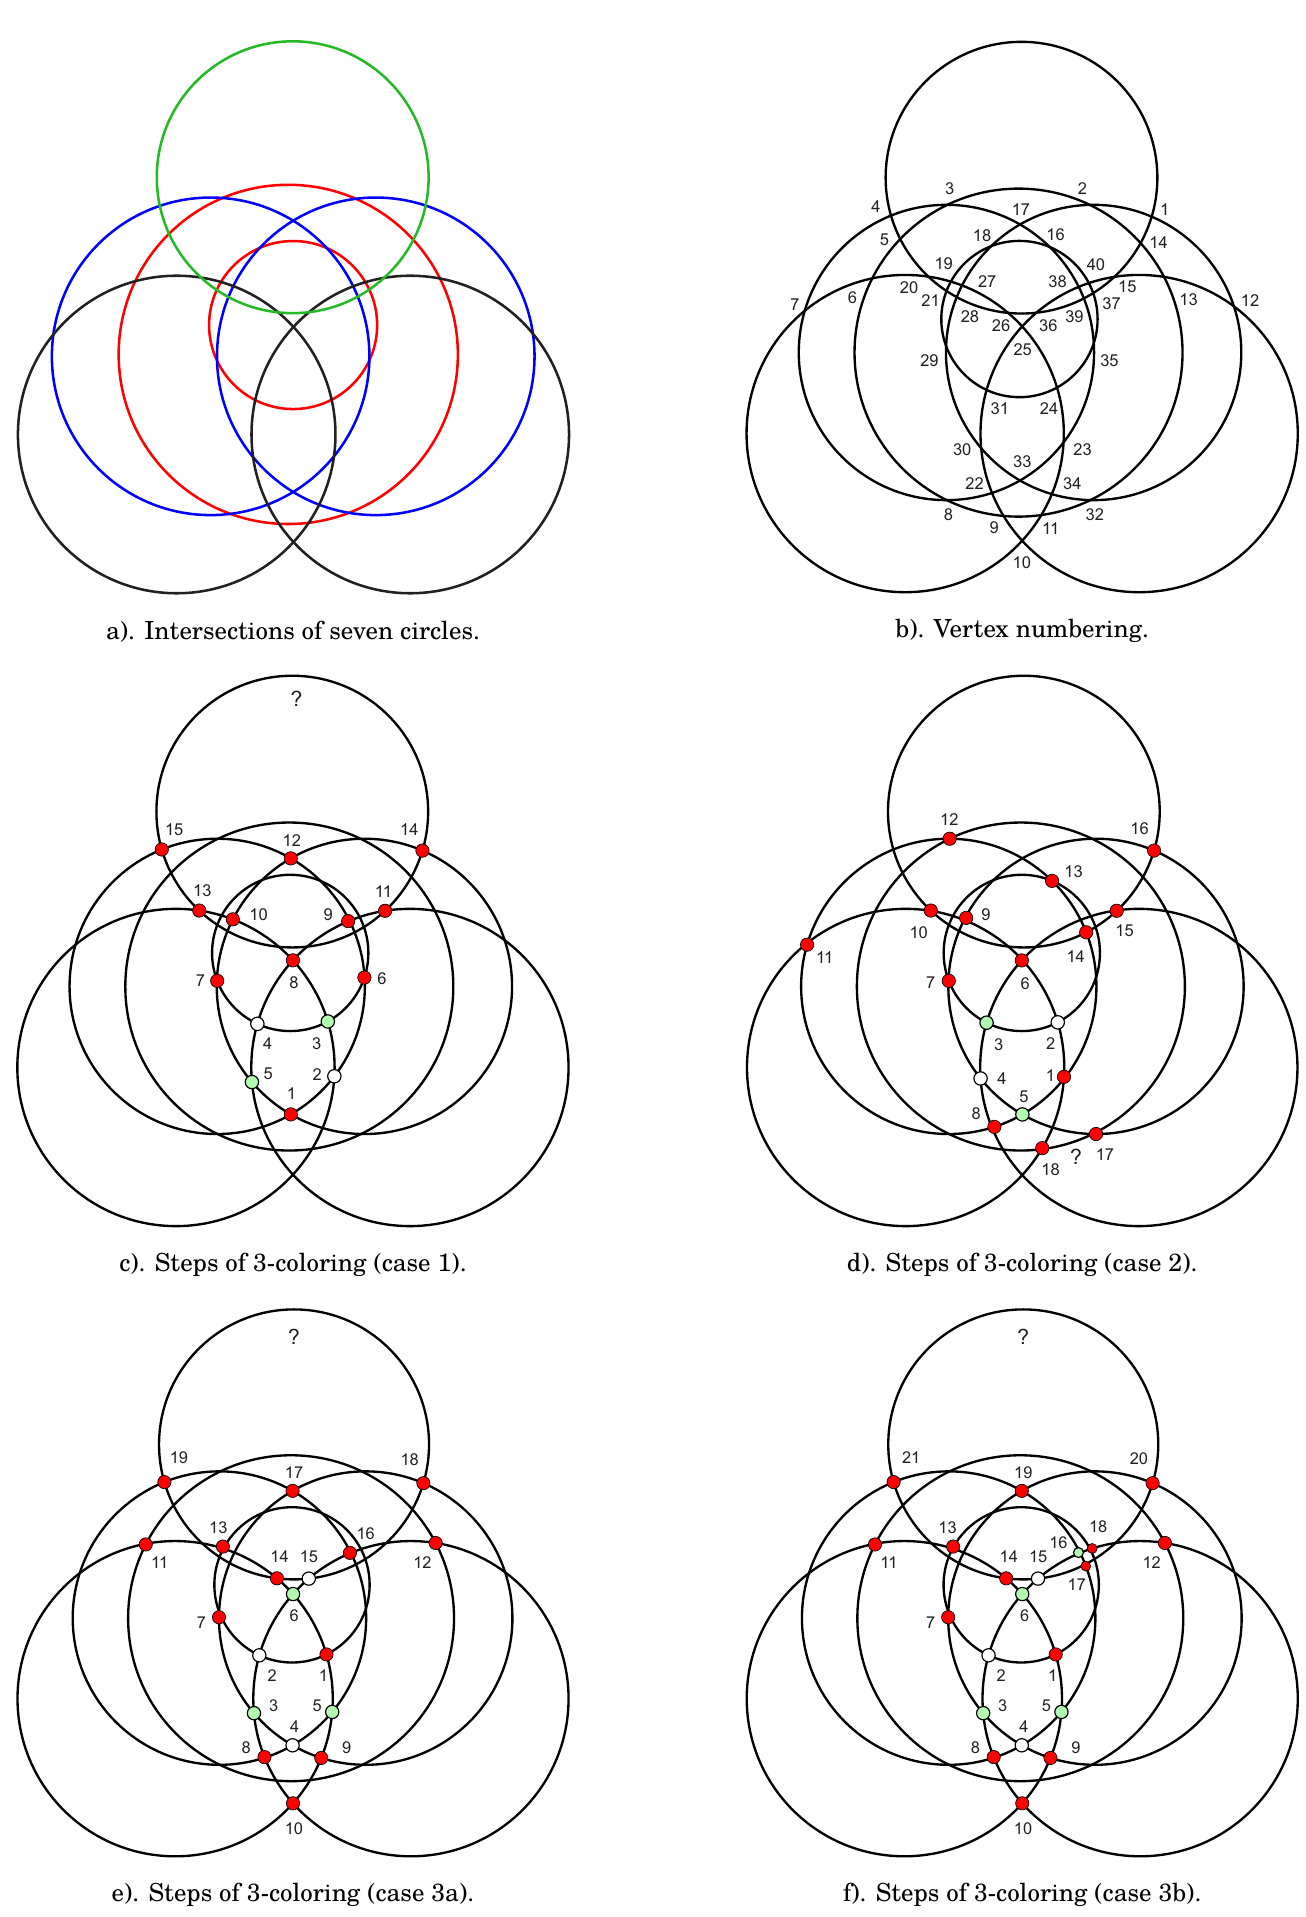
Figure 2: The edge 4-critical Koester graph K 2 of order